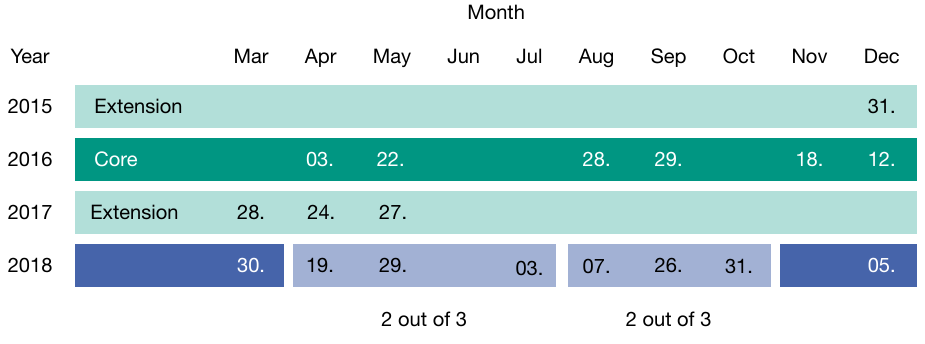
Figure 6. Available Sentinel-2 satellite images in the area of interest in 2015–2017 (green) and 2018